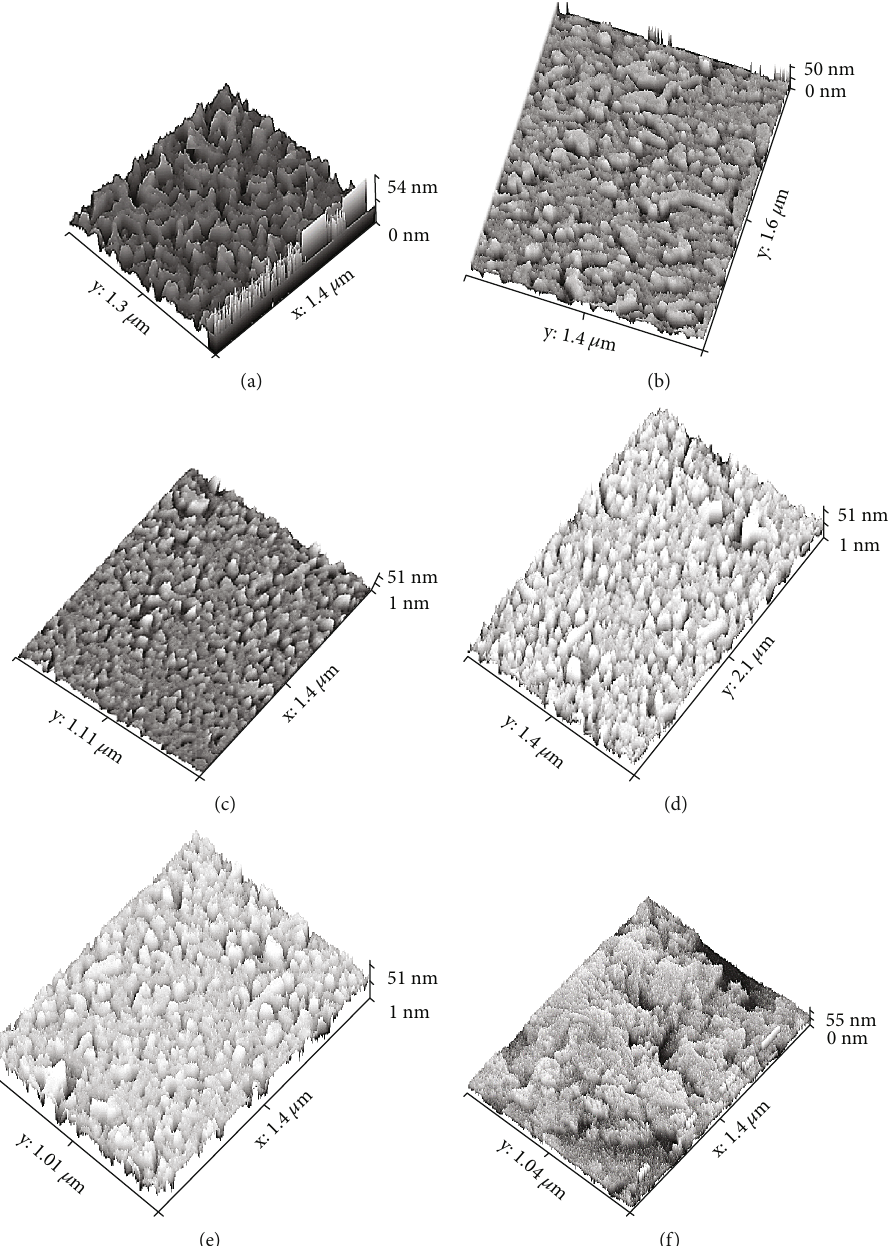
Figure 3: The cross-section and morphology of (a) P3MA, (b – e) P3MA/PbS-QD composite in di ff erent Pb 2+ ion concentrations of 0.01, 0.03, 0.05, and 0.07M, respectively, and (f)